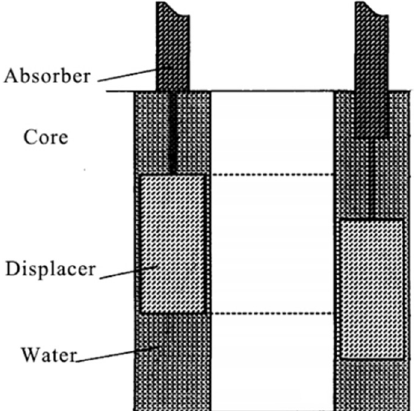
Fig. 6. Control rod falling process.